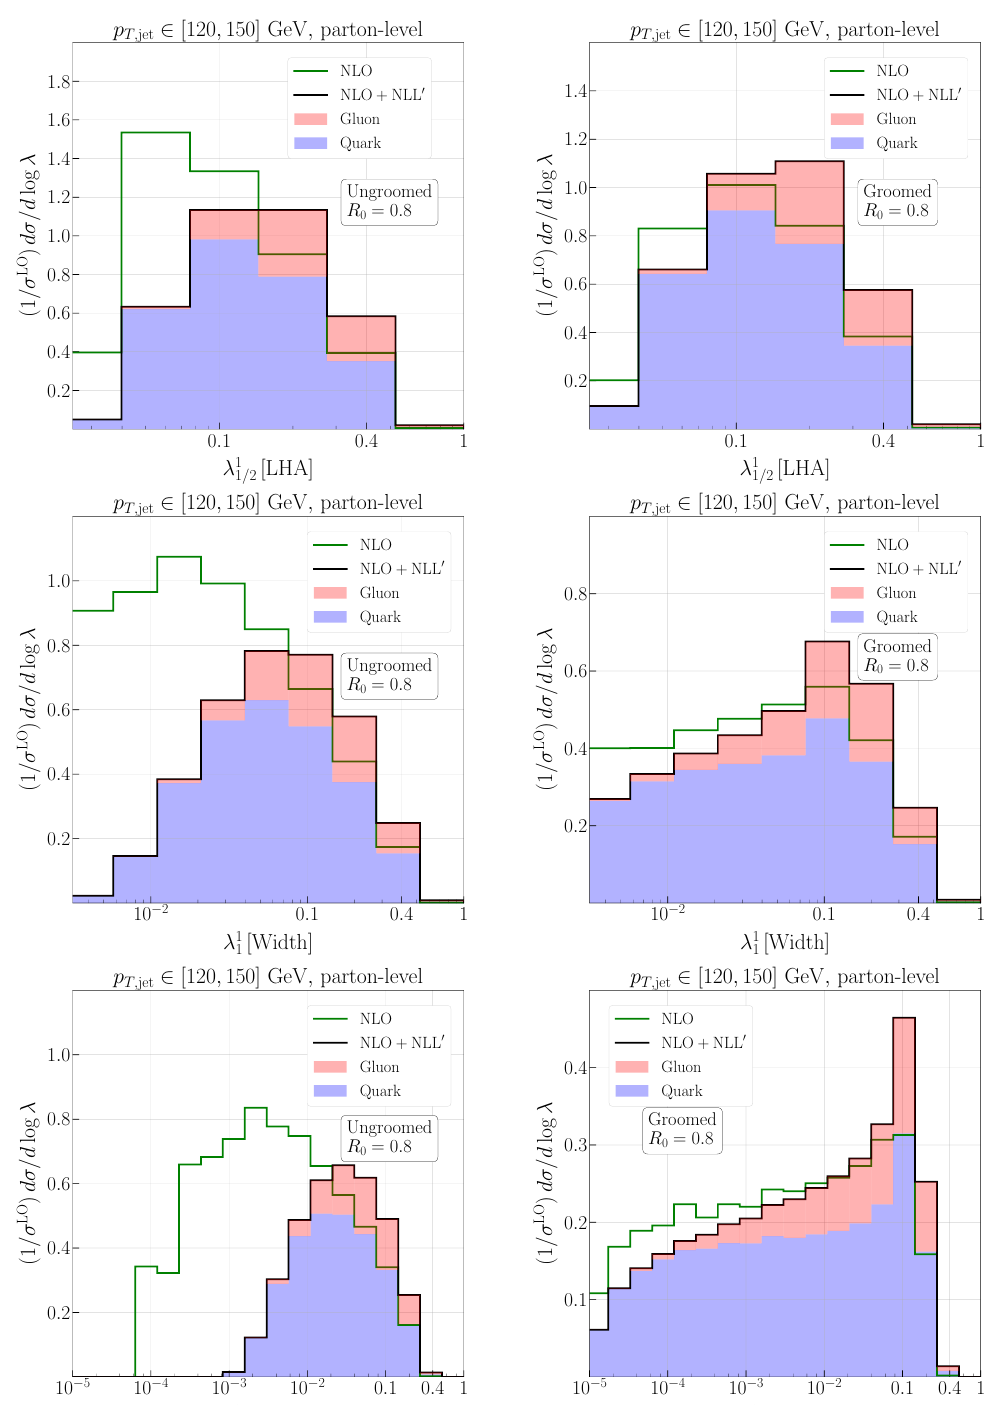
Figure 8 . Fixed-order and matched predictions at NLO and NLO + NLL 0 accuracy, for ungroomed (left row) and groomed (right row) angularities, for α ∈ { 1 / 2 , 1 , 2 } . The colour scheme indicates how the gluon (red) and quark (blue) channel as identified with the BSZ algorithm stack up to form the NLO + NLL 0 prediction. The jet transverse momentum is constrained to p T, jet ∈ [120 , 150]